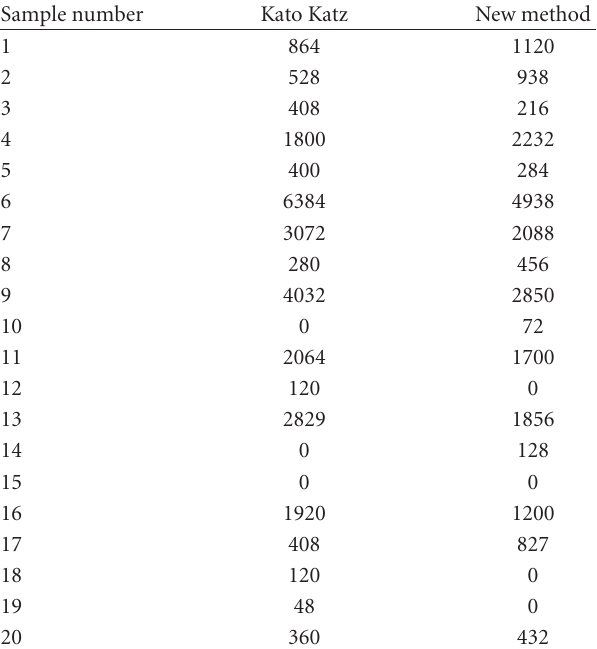
Table 1: Comparative counts in